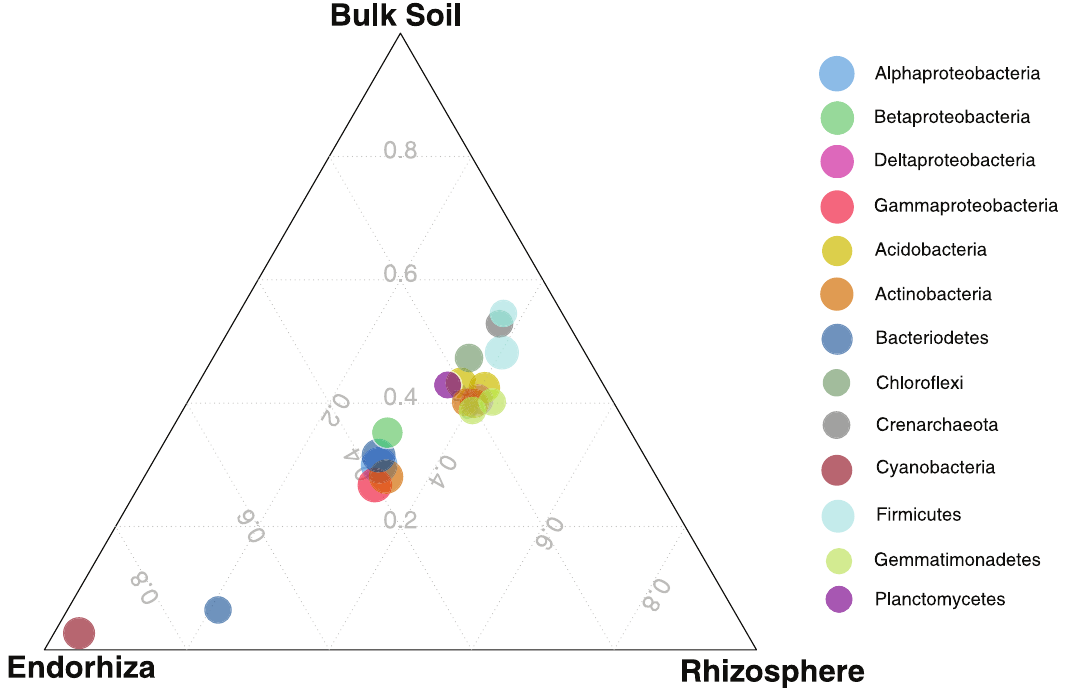
Figure 4. Ternary plot of distribution of bacterial taxonomic groups among sample types in the second experiment. Size of circles proportional to the log of the total abundance, taxonomic groups are all phylum-level, except for Proteobacteria, which is by class. doi:10.1371/journal.pone.0099641.g004 PLOS ONE |